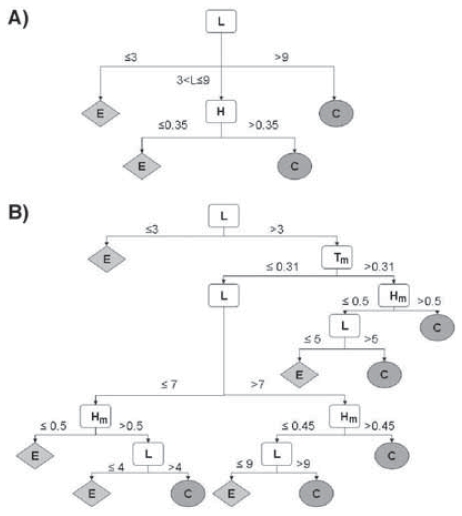
Decision trees for predicting the edge (E) or central (C) position of β-strandsA) The simplest decision tree, leading to 77% of good predictions.B) A more complex tree giving 80% of good predictions.L: length of the β-strand; H: hydrophobicity of the β-strand;T: topohydrophobicity. The m index stands for mean values.